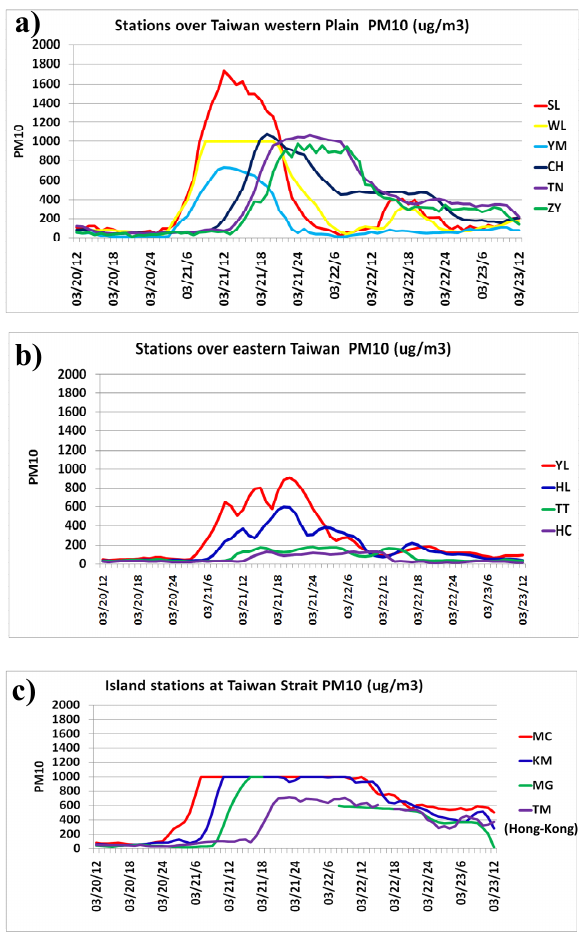
Fig. 2. (a) Hourly concentration variation of PM 10 (µgm − 3 ) for the selected stations (SL, WL, YM, CH, TN and ZY) at Taiwan’s western plain during 12:00LST, 20–23 March 2010. (b) Hourly concentration variation of PM 10 (µgm − 3 ) for the selected stations (YL, HL, TT and HC) at eastern Taiwan during 12:00LST, 20–23 March 2010. (c) Hourly concentration variation of PM 10 (µgm − 3 ) for the island stations (MC, KM and MG) in the Taiwan Strait and station TM at Hong Kong during 12:00LST, 20–23 March 2010.